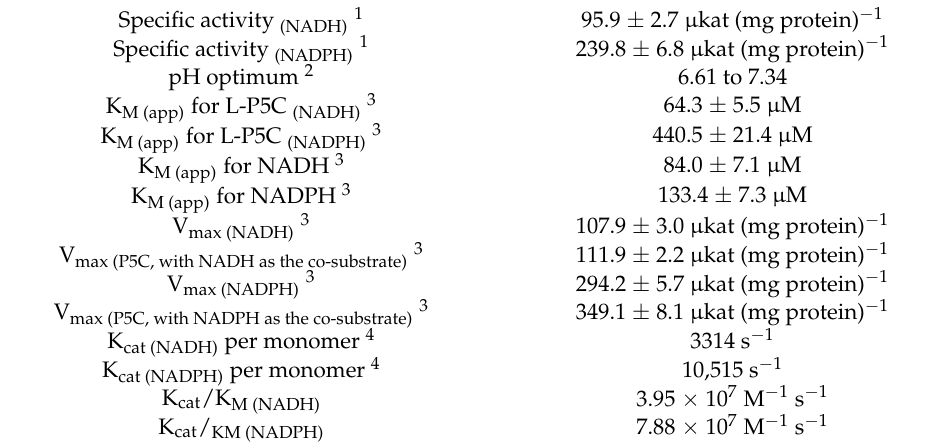
Table 2. Properties of Saccharomyces cerevisiae P5C reductase.